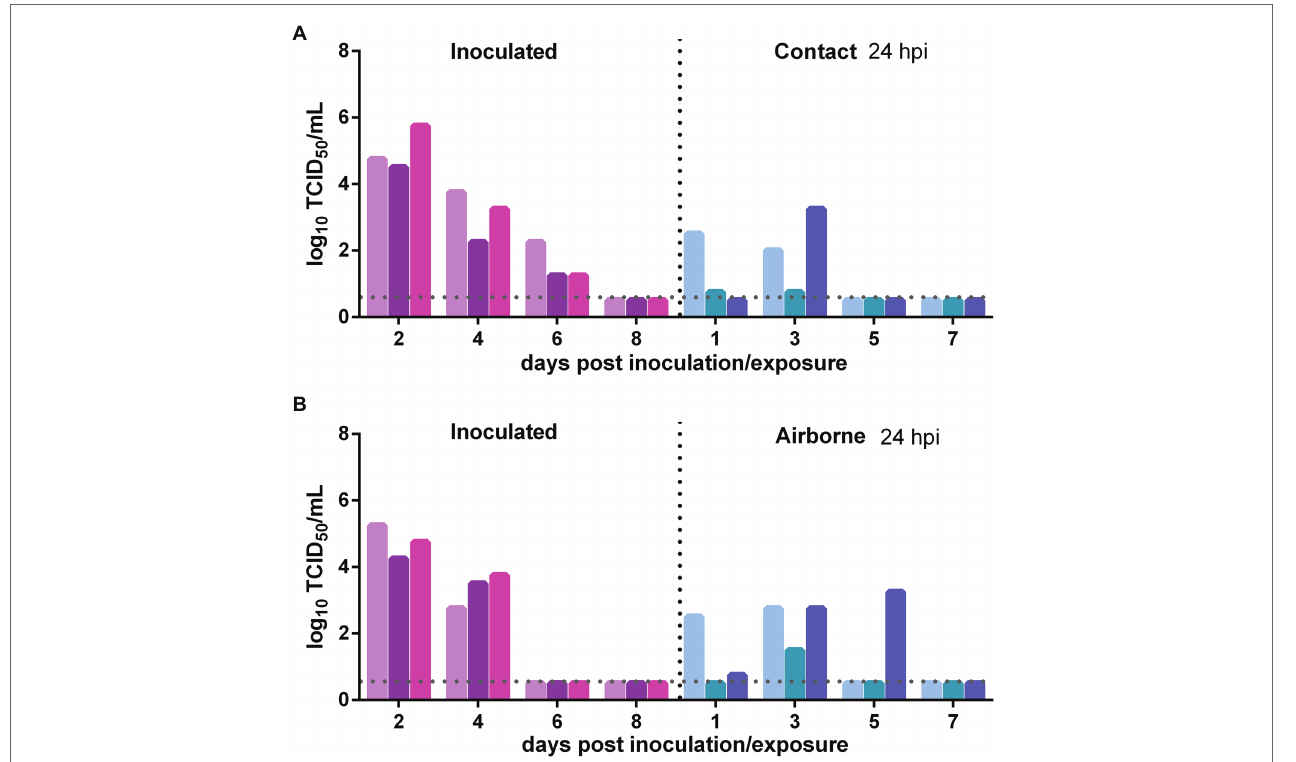
FIGURE 2 | Transmission of SARS-CoV-2 from initially infected Syrian hamsters to previously infected Syrian hamsters 24 h post inoculation (hpi). The dotted line represents the detection limit of viral titers and colored bars are indicating individual animals. The time between infection and start of the transmission experiment was showed on the upper right side. (A) Viral titers detected in the nasal washes of the donors inoculated with 10 6 TCID 50 of SARS-CoV-2 and previously infected contacts. (B) Viral titers detected in the nasal washes of donors inoculated with SARS-CoV-2 and previously infected recipients in the airborne transmission